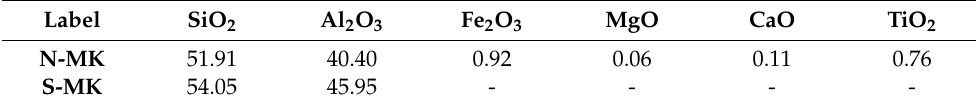
Table 1. Chemical composition (wt%) of the N-MK and S-MK and SiO 2 -sol. Label